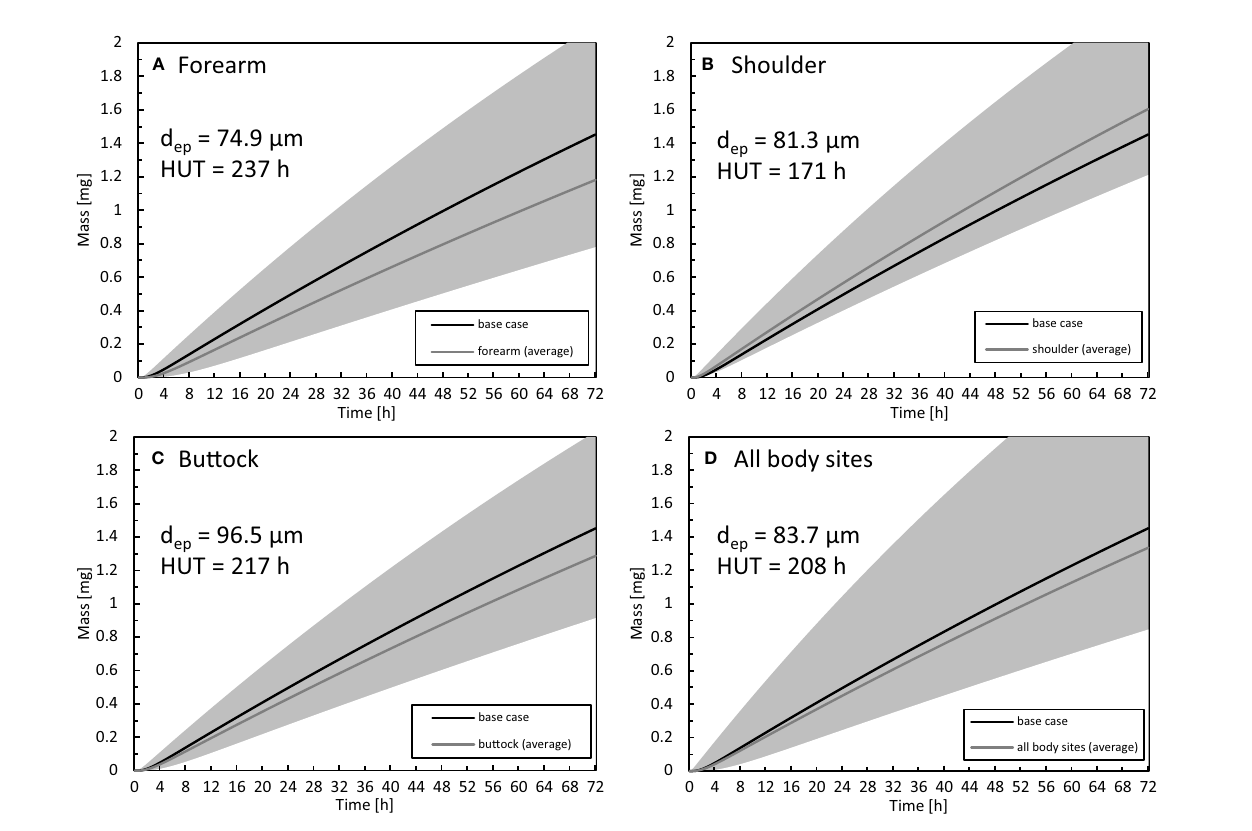
FIGURE 11 | Cumulative amount of drug taken up in the blood as a function of time for the forearm (A) , shoulder (B) , buttock (C) epidermal thickness averaged for all body sites (D). For comparison, the results of the base case are also depicted. The range corresponding to the simulated average thickness values +/- 2 x standard deviation (µ i -/+ 2 s i ) is depicted in gray to quantify interpatient variability via the 2.5% and 97.5% quantiles. The thickness of the epidermis (d ep ) and half- uptake time (HUT) are indicated as